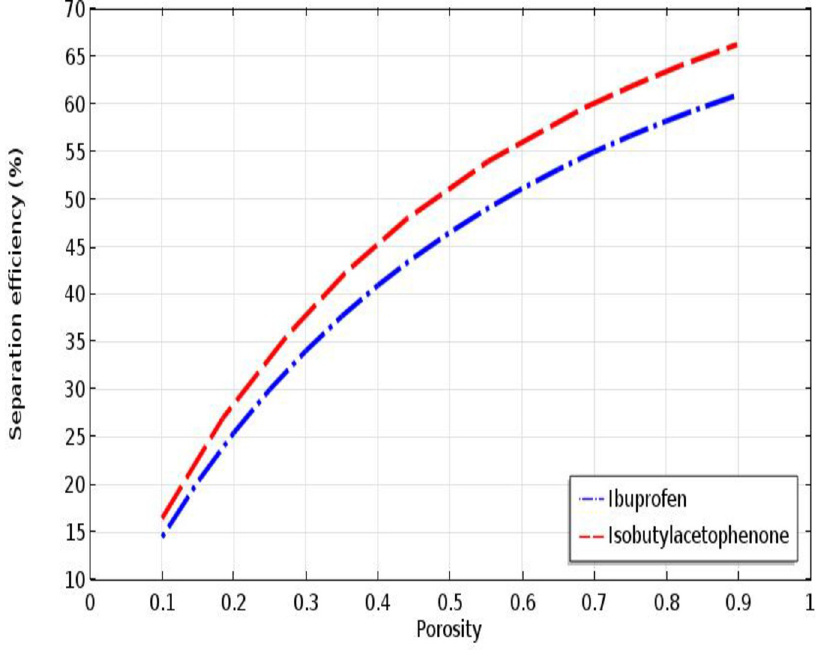
Fig 8. Effect of porosity parameter on the IP and 4-IBAP solutes molecular separation.